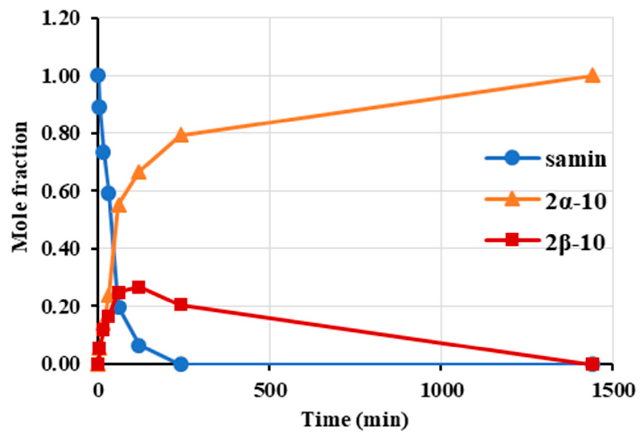
Figure 6. Time course of the evolution of samin ( 5 ), 2 α -10 , and 2 β -10 in mole fraction monitored using 1 H NMR spectroscopy (400 MHz).